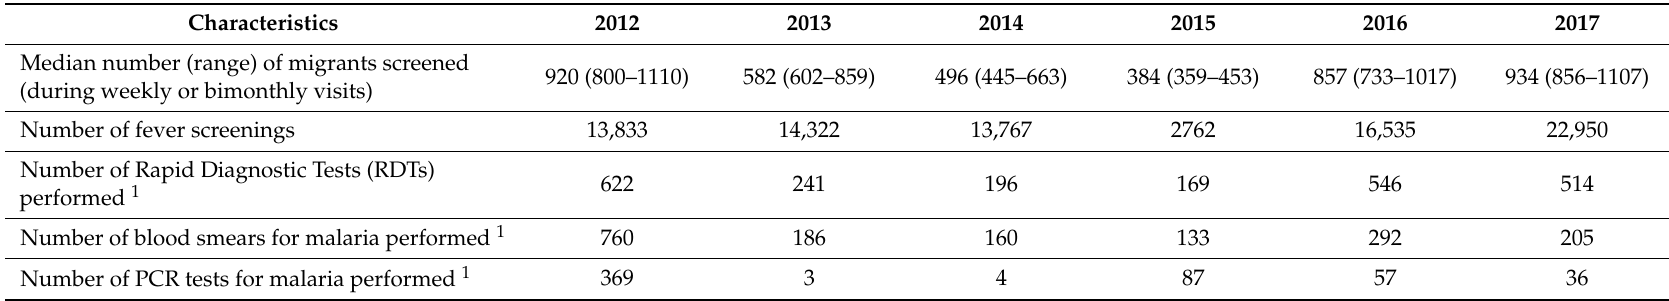
Table 2. Number of migrants screened, fever screenings and diagnostic tests performed per year, malaria Pro-Active Active Case Detection program, Evrotas Municipality,